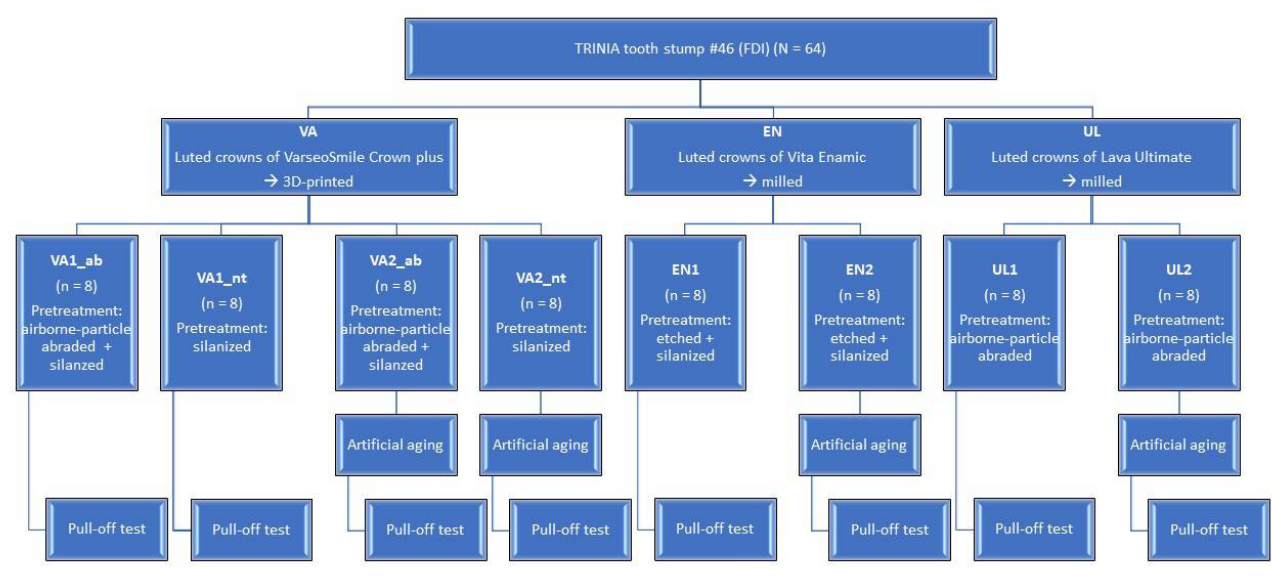
Figure 1. Experimental setup. Table 1. Overview of tested materials and their group-specific luting protocols (Al 2 O 3 : airborne- particle abraded with aluminum oxide; HF: etched with hydrofluoric acid). a data from the manu-